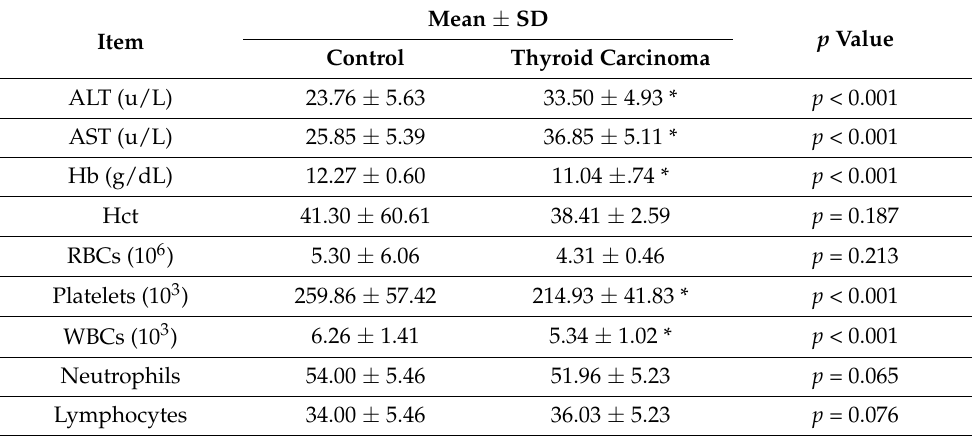
Table 4. Mean ± SD of liver enzymes and CBC indices in the different studied